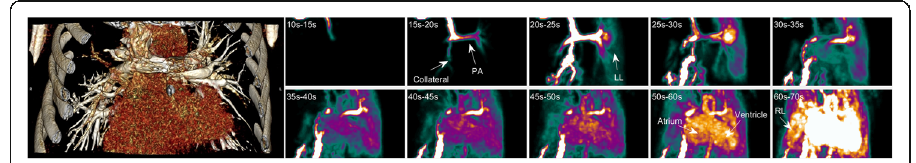
Fig. 2 Left : Volume rendering of contrast CT of the superior mediastinum showing the pulmonary arteries. Right : Dynamic MIP PET images of 15 O-water following a bolus injection. Collaterals are shown together with the pulmonary arteries (PA), the atrium, and ventricle. The left lung (LL) is perfused before the right lung